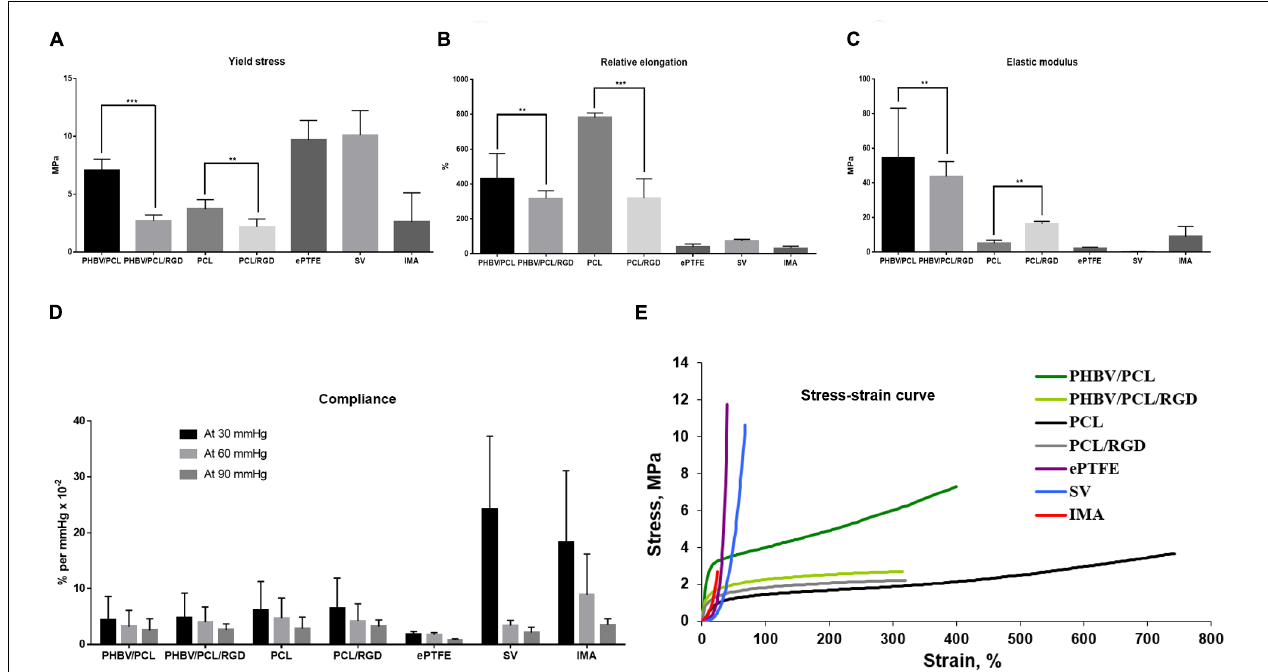
FIGURE 4 | PHBV/PCL and PCL vascular grafts with RGD peptides have improved physico-mechanical properties. (A) Modification with RGD peptides decreased durability of PHBV/PCL and PCL grafts almost to the values of internal mammary artery (IMA). (B) Modification with RGD peptides reduced elasticity of PHBV/PCL and PCL grafts; however, it was still far from that of IMA. (C) Modification with RGD peptides decreased stiffness of PHBV/PCL grafts but increased stiffness of PCL grafts; for PCL grafts, stiffness was close to that of IMA. (D) Measurement of compliance found no significant differences for both PHBV/PCL and PCL grafts with and without RGD peptides. (E) Calculation of stress-strain curve of PHBV/PCL and PCL grafts with and without RGD peptides revealed it is still far from that of IMA. Data are represented as median with interquartile range, ∗∗ P < 0.01, ∗∗∗ P < 0.001, Mann–Whitney U